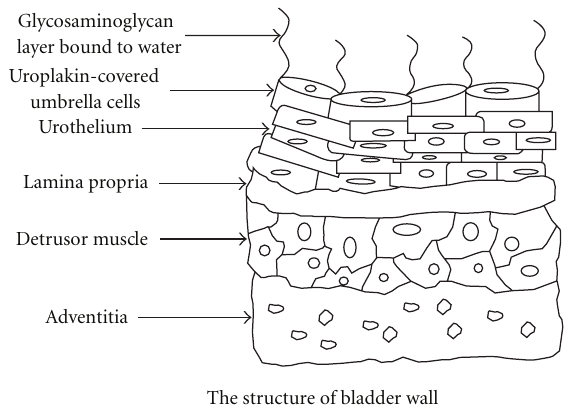
Figure 4: The structure of the urinary bladder wall and urothelium.